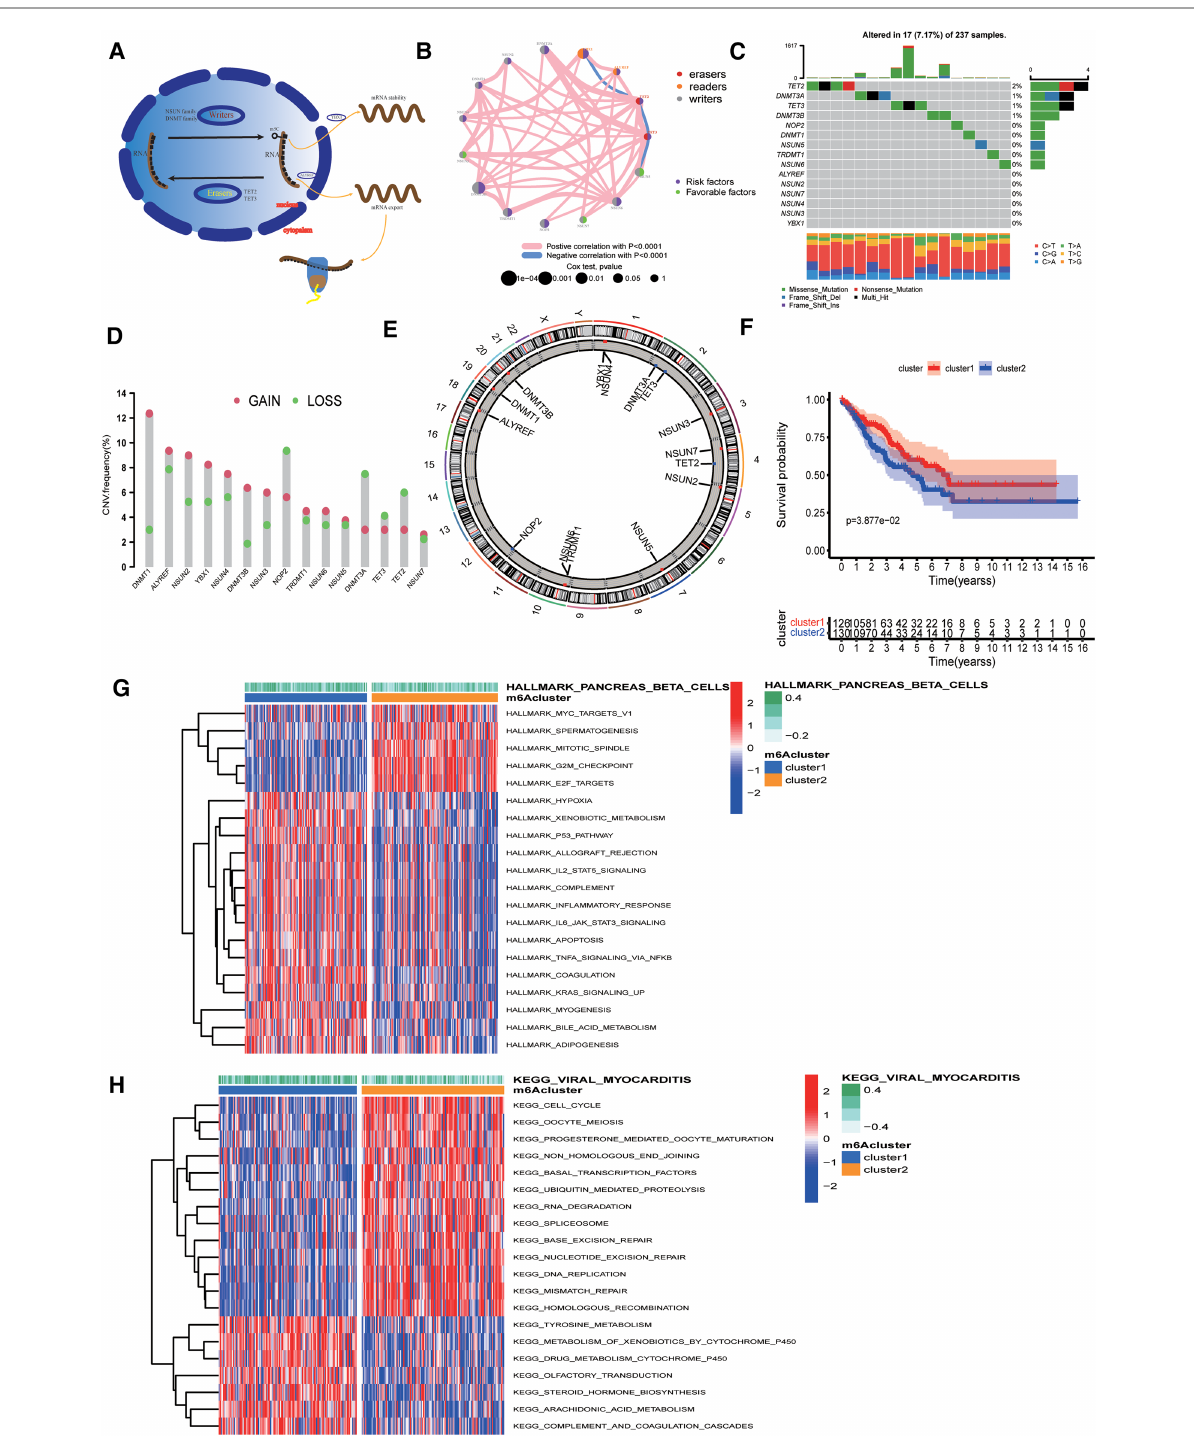
FIGURE 1 Landscape of genetic alterations of 5-methylcytosine (m5C) regulators in sarcoma. ( A ) Biological functions of m5C in RNA metabolism. ( B ) Interaction of 15 m5C regulators. The color represents the type of m5c. The size of the circle indicates the prognostic effect of the p -value assessment. The color inside the circle represents the prognostic effect, including protective factors (green) and risk factors (purple). ( C ) Mutation frequencies of 15 m5C regulators in 256 TCGA sarcoma samples. ( D ) Copy number variation (CNV) mutation frequencies of the 15 m5C regulators. ( E ) Location of CNV alterations of m5C regulators on chromosomes. ( F ) Survival curves showing a poor prognosis for cluster2. ( G ) Results of Hallmarker genomic enrichment analysis. ( H ) Results of KEGG set enrichment